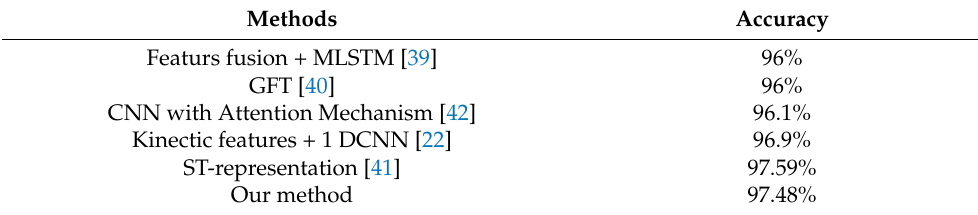
Table 6. Compared with the state-of the art methods on UTkinect-3D dataset.